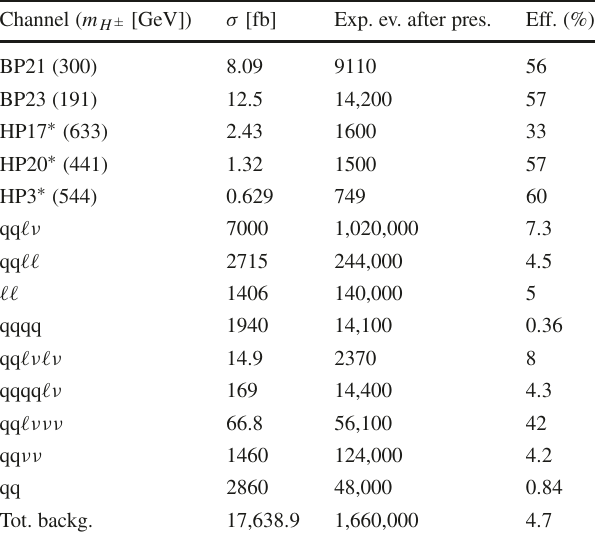
Table 3 Results of the event preselection at √ s 1 . 5TeV CLIC run- = ning stage for the benchmark points and background channels consid- ered in the full simulation study. Shown are cross sections σ , numbers of events expected after preselection cuts for an integrated luminos- ity of 2ab − 1 and the preselection efficiency. For signal scenarios, the mass scale of the charged IDM scalar is indicated in parenthesis, for other model parameters see Table 1. Signal scenarios with off-shell W ± production are marked with a star